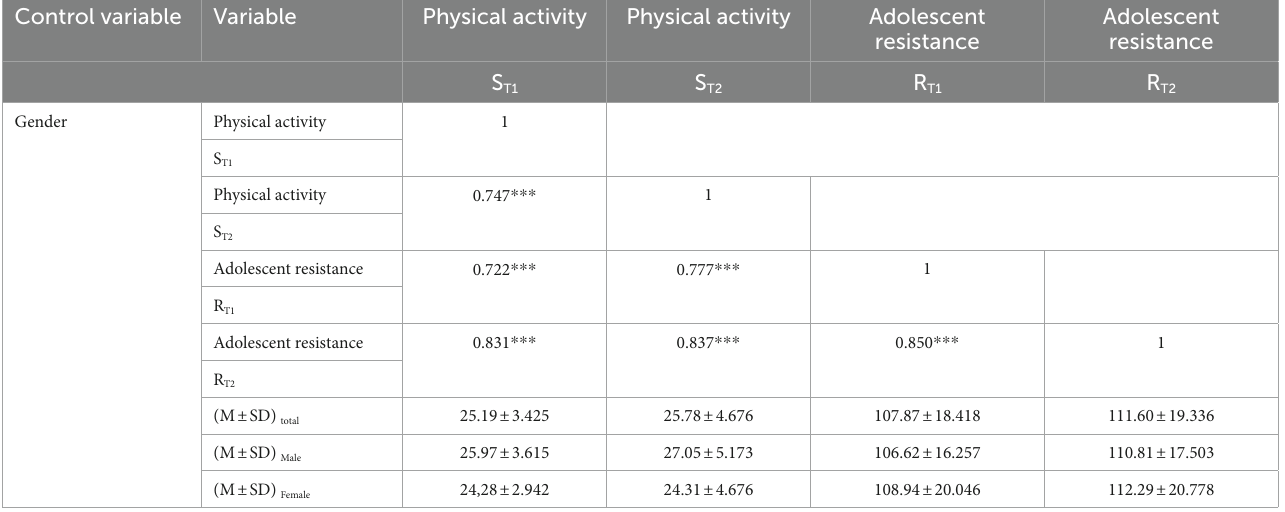
TABLE 4 Descriptive statistics and results of the partial correlation analysis of the relationship between physical activity and adolescent resilience. Control variable